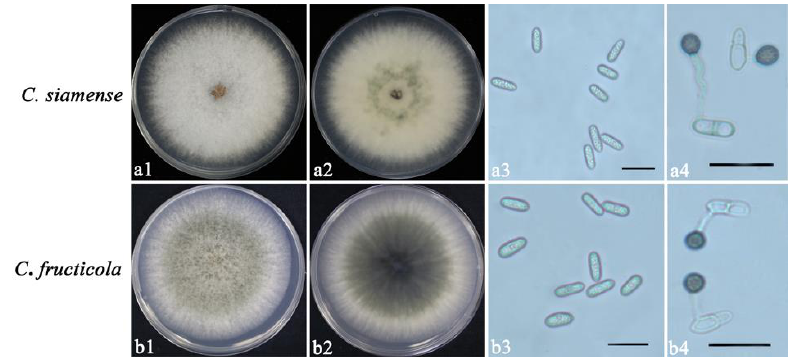
Figure 1. Colony morphology of Colletotrichum siamense and C. fructicola from the top of the PDA plate (a1 – b1), from the underside of the PDA plate (a2 – b2), conidia (a3 – b3), and appressoria (a4 – b4), scale bar: (a3 – b3, a4 – b4) = 20 µm. Table 2. Size of spores and appressoria, growth rates, and sporulation of Colletotrichum siamense and C. fructicola .